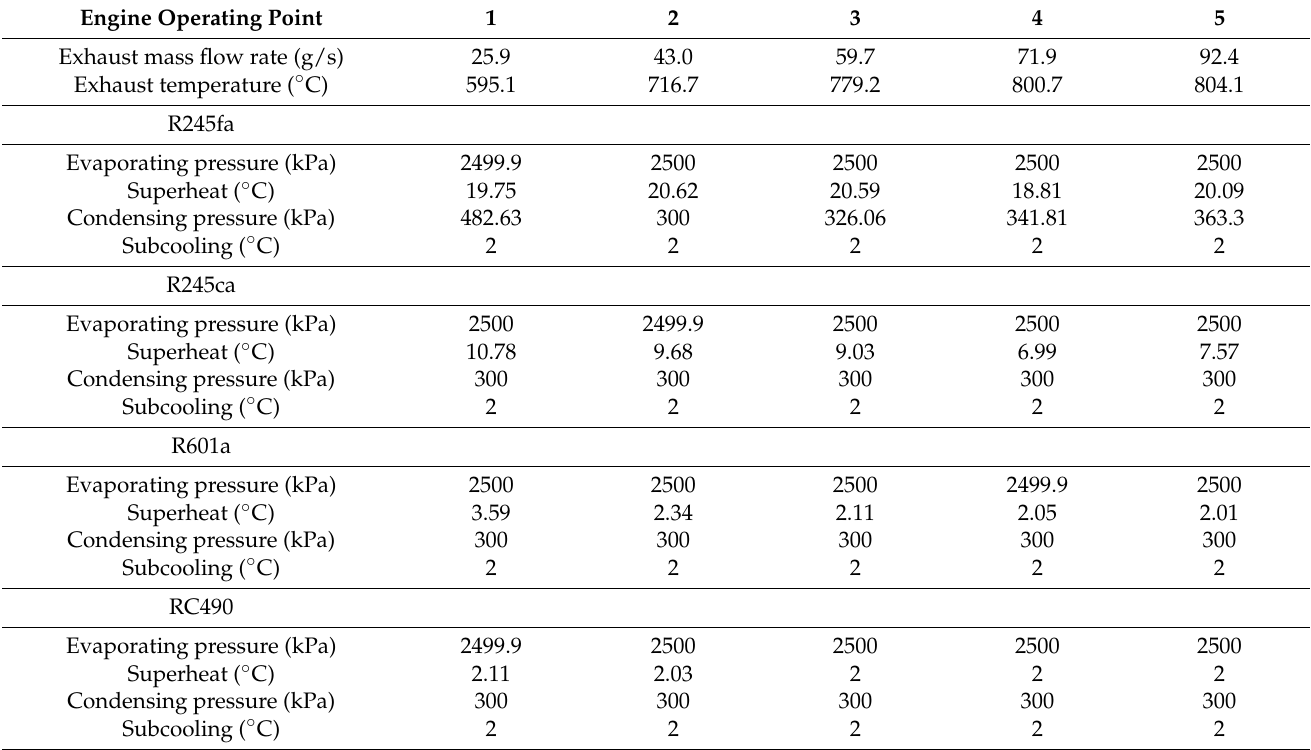
Table 11. The optimal ORC operating